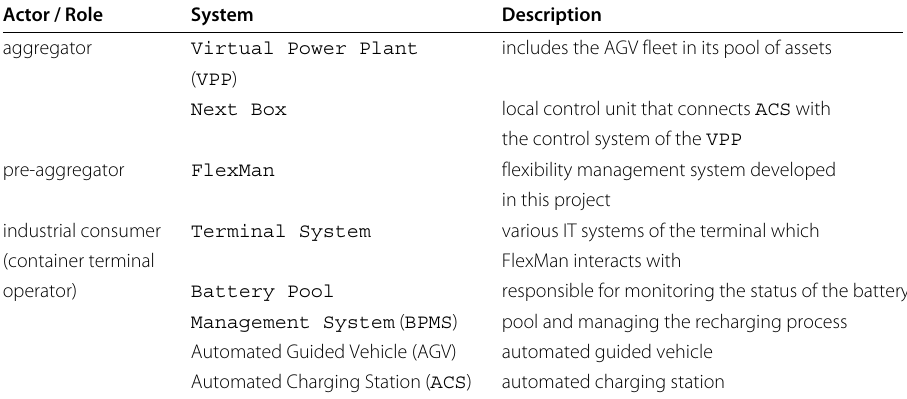
Table 1 Systems interacting to perform the use